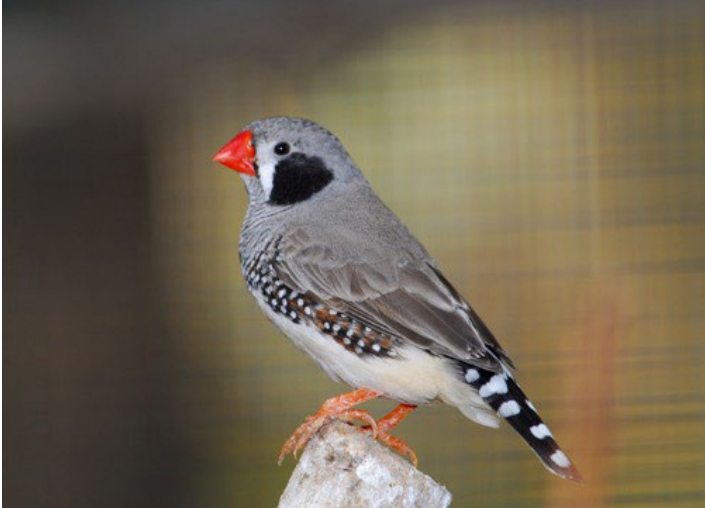
Figure 2. Zebra finch is depicted. Symmetrically banded males and females are preferred by an individual of the opposite sex.